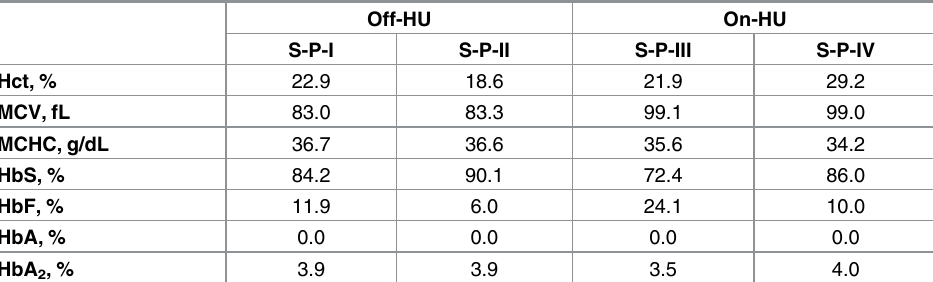
Table 1. Selected hematologic parameters from four SCD patients.